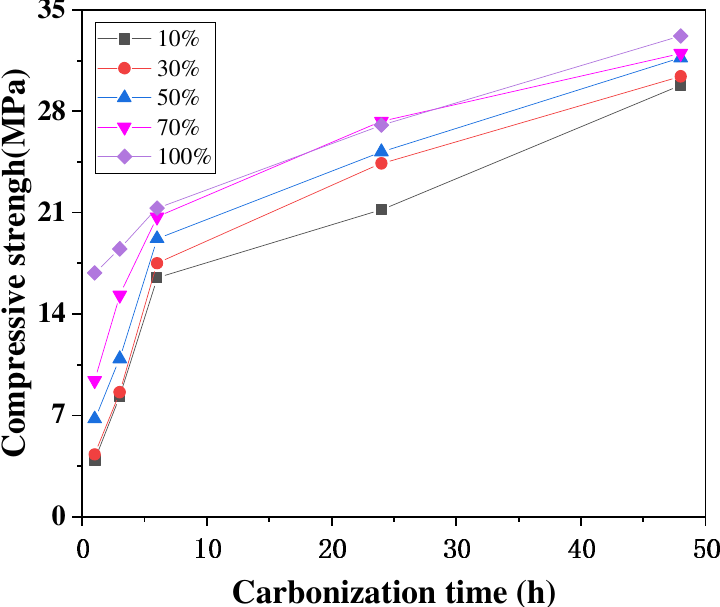
Figure 5. Relationship between carbonization time and compressive strength [46].